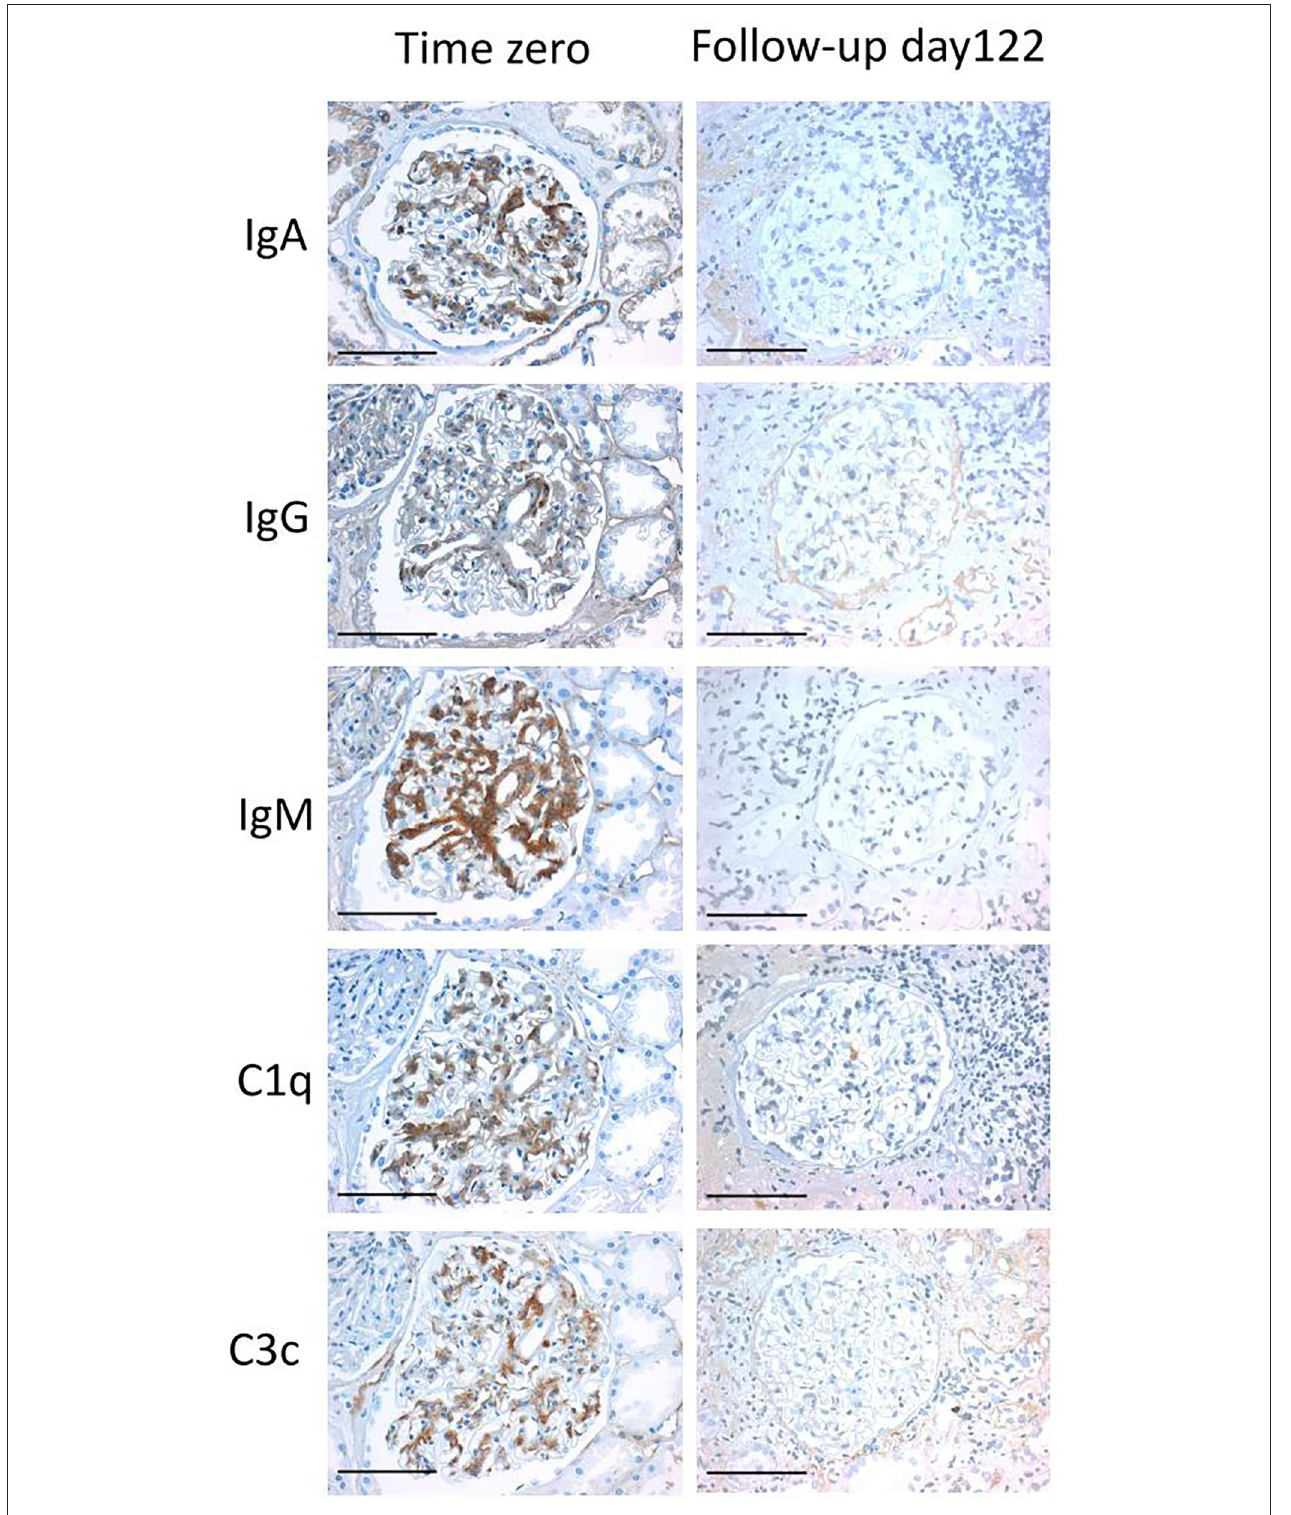
FIGURE 3 | Fullhouse pattern disappearing in the follow-up biopsy. An example of an immunohistochemical fullhouse pattern is depicted in a time zero biopsy (left column), which has completely disappeared in the follow-up biopsy at day 122 (right column). All light microscopic pictures were taken with an AxioCam MRc and an Imager.A1 Axio microscope (Zeiss, Germany) at an original magnification of 400x. Scale bars indicate 100 µ m.